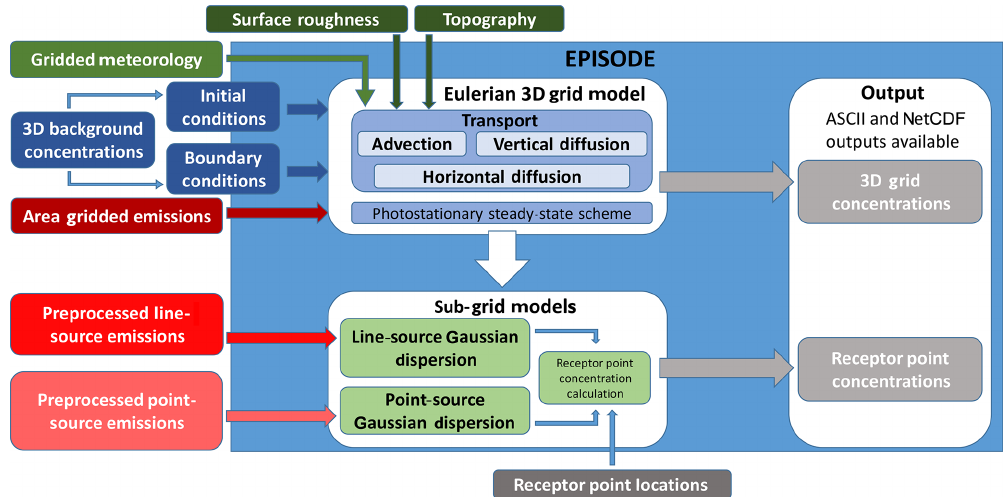
Figure 1. Schematic diagram of the EPISODE model. The large blue box represents operations carried out during the execution of the EPISODE model. The components of the EPISODE model are the Eulerian grid model and the sub-grid models. The inputs for EPISODE are specified on the